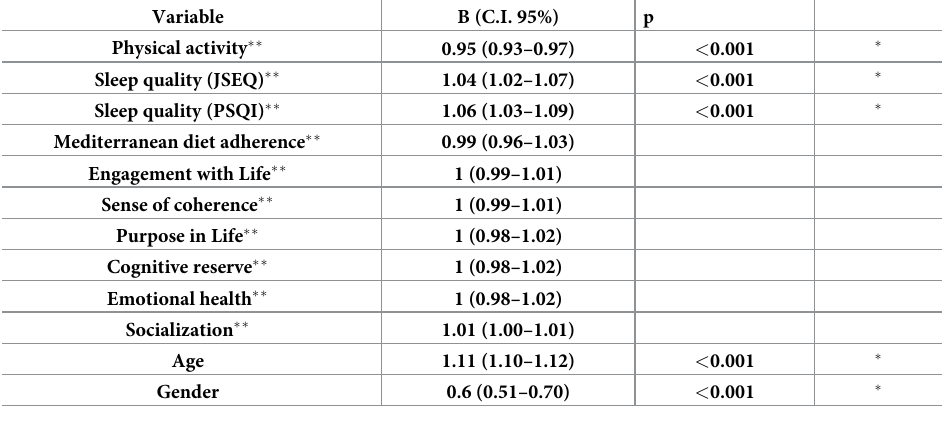
Table 5. Multiple logistic binomial regression using any medical condition (not neurological or psychiatric) as dependent variable, lifestyles at baseline as independent variables, and gender and age as covariates. Reported val- ues are standardized beta